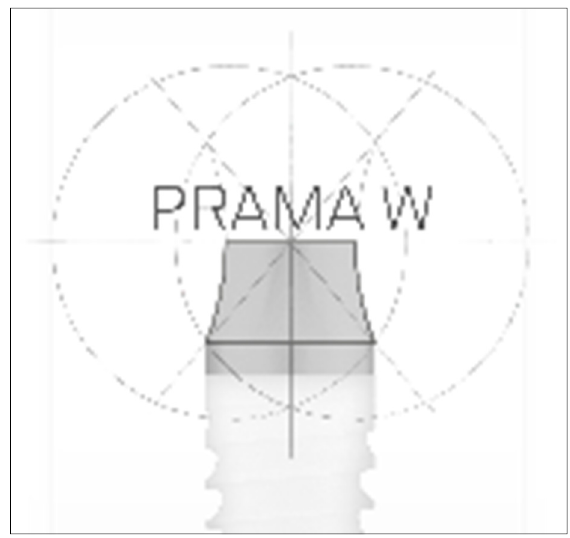
Figure 1. Geometry of the implant neck. The implant neck also underwent an anodic passivation process that gave it the characteristic golden pale yellow color. The so-called ZirTi body of the implant was sand-blasted with zirconium and acid-etched with mineral acids (Figure